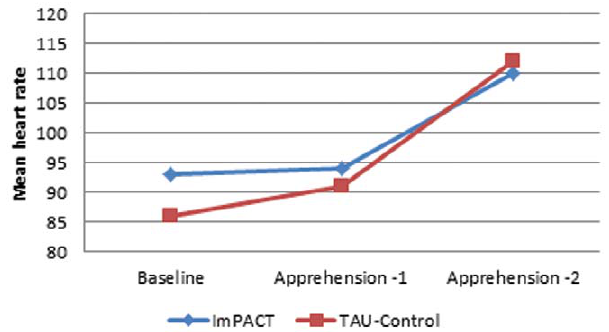
Figure 2. Illustration of a significant difference in stress response as measured with free salivary cortisol (in ug/dL) for participants who received the ImPACT program or training as usual (TAU-Control) before and after a live and stressful simulation.